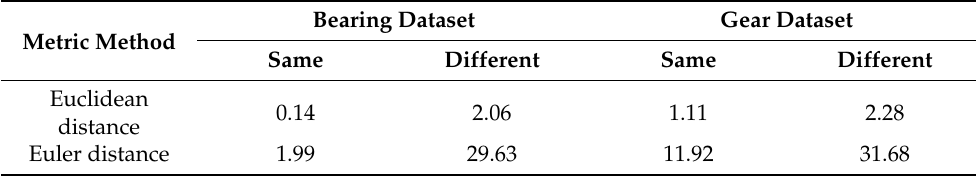
Table 1. Comparison of different distance